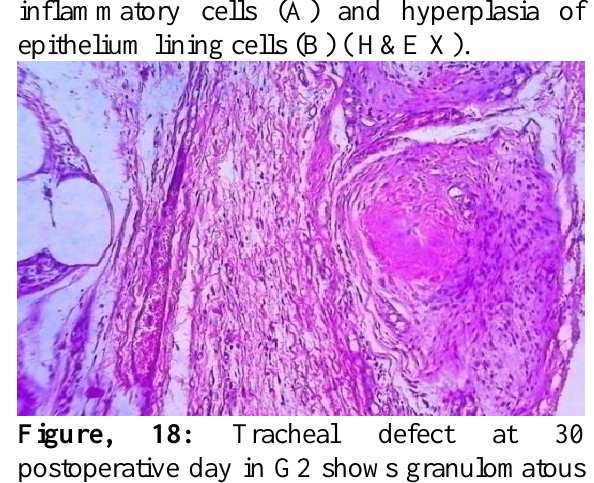
Figure, 18: Tracheal defect at 30 postoperative day in G2 shows granulomatous reaction (chronic) (H&EX10).